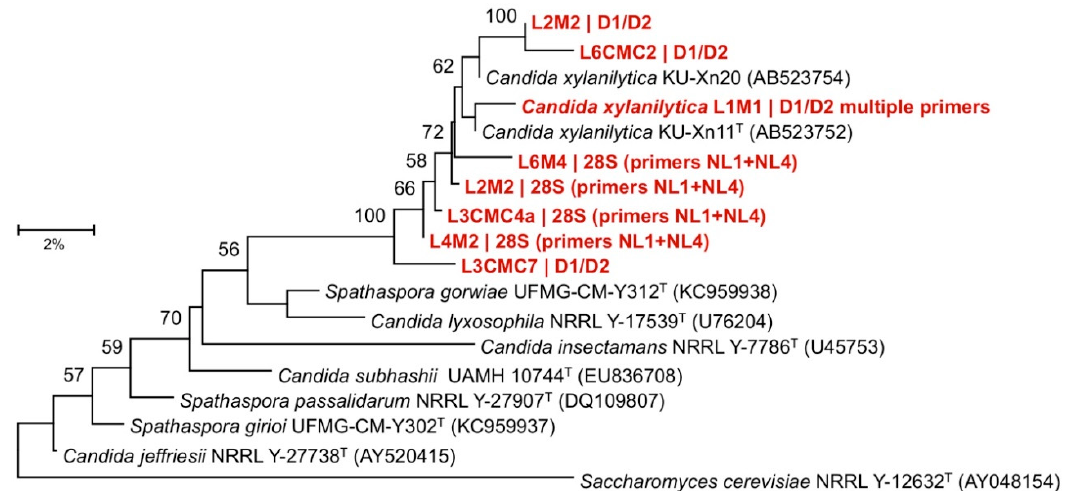
Figure 3. Phylogenetic tree based on D1/D2 region sequence analysis. Samples in red are putative Candida xylanolytica strains isolated from larval midguts. The tree was constructed by the neighbor-joining method and Saccharomyces cerevisiae was used as the outgroup. Bootstrap values (expressed as percentages of 1000 replications) greater than 50% are shown at branch points. Scale bar represents 2% sequence divergence. T: type strain. Figure Credit: Ming-Ju Chen. Table 2. Candida xylanilytica strain cellulase test with tetrazolium blue method. Microbes were reared in nutrient broth, then a sample incubated with CMC in a bu ff er for 13 min, boiled with tetrazolium blue reagent for 5 min to stop the reaction, and the color change measured using a spectrophotometer. By calibrating the machine with known concentrations of glucose, the concentration (M) of reducing sugars can be quantified. The samples are Candida xylanilytica strains from Oryctes rhinoceros larvae. The positive control is Chaetomium globosum . The negative control is sterile nutrient